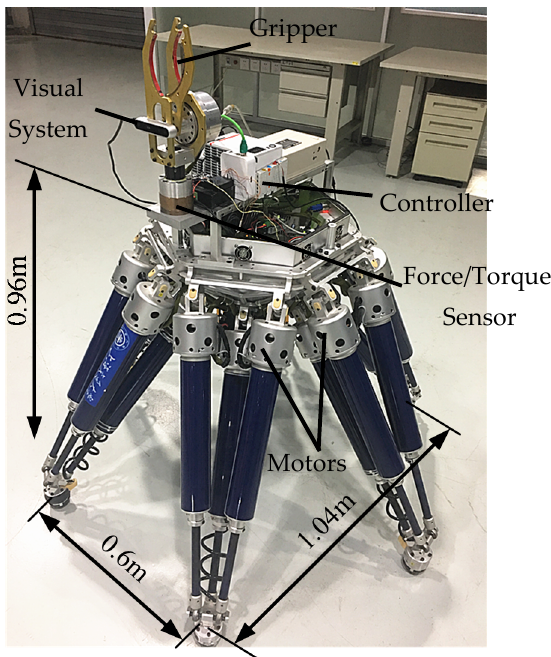
Figure 1. Prototype of the six-parallel-legged robot.